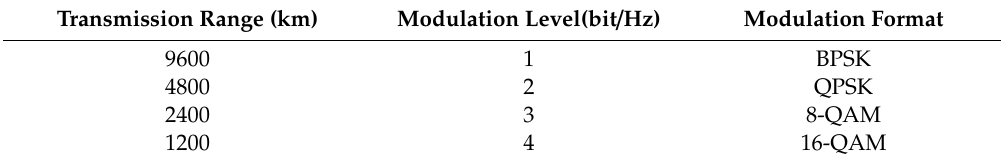
Table 1. Modulation formats vs. their corresponding transmission